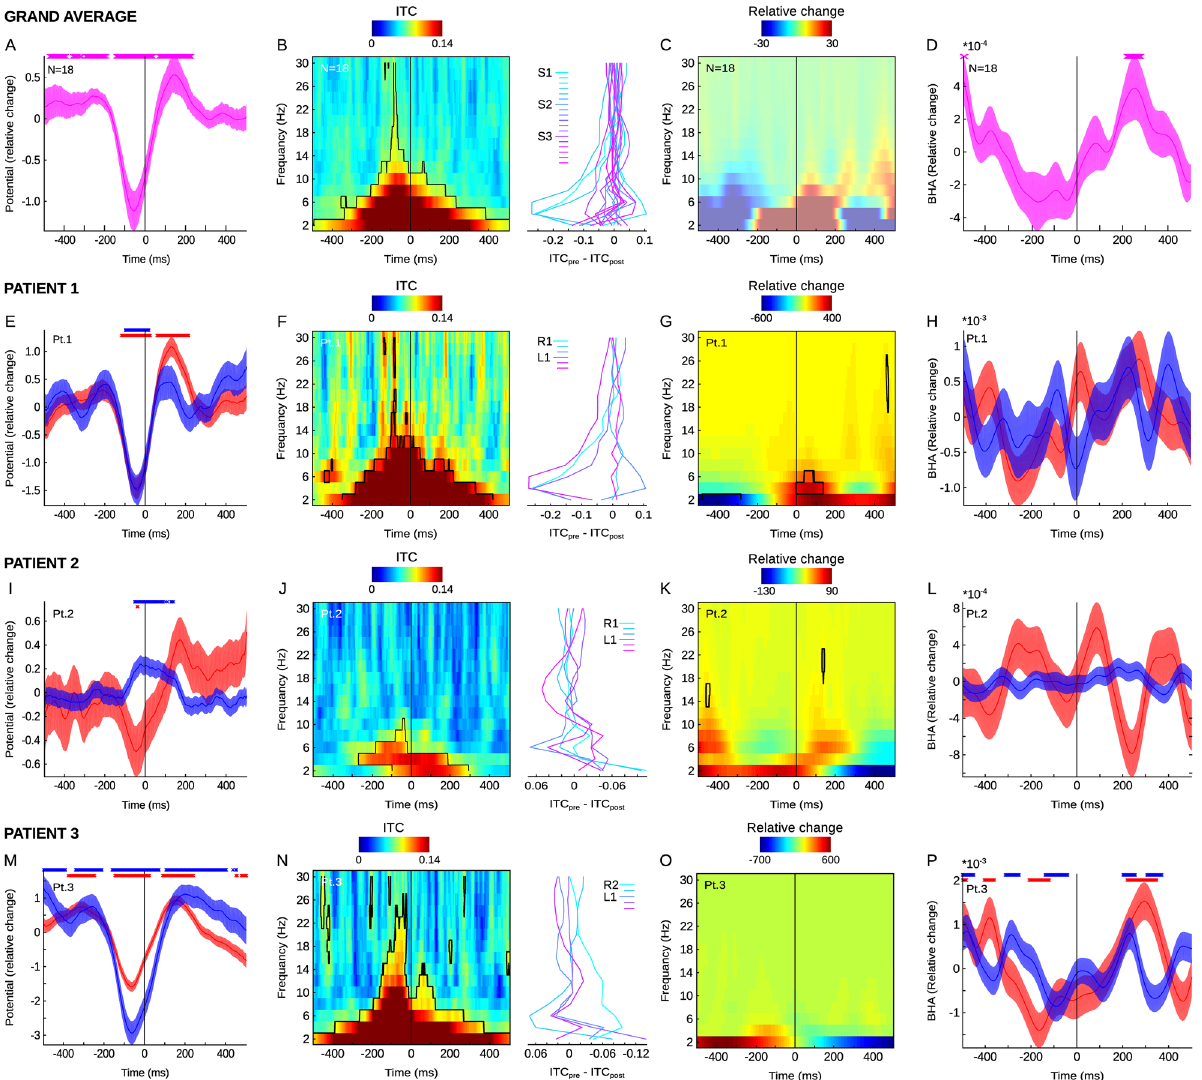
Figure 3. Blink offset-locked neural activity in human ANT. ( A ) Grand average for blink offset-locked field potentials (N = 18 ANT channels, 3 patients). Vertical lines show the point of blink offset (i.e., onset of visual input). Markers above indicate significant time points (permutation test p < 0.05). ( B ) Color map shows ITC (time on x-axis, frequency on y-axis). Contours depict significant time–frequency points (permutation test p < 0.05). Vertical black line indicates blink offset (i.e., the beginning of visual input). Line plots on the right side indicate ITC change from pre- (− 300: − 100 ms) to post- blink offset (0:100 ms) time window separately for each channel. ( C ) Color map shows blink offset locked power relative to trial average (time on x-axis, frequency on y-axis). No change from surrogate distribution (permutation test p < 0.05). ( D ) Blink offset locked BHA (80–180 Hz). Vertical black line indicates blink offset (i.e., beginning of visual input). Markers above indicate significant time points (permutation test p < 0.05). ( E ) Blink offset-locked field potentials (patient 1) from channels on the right ANT (blue) and left ANT (red). Vertical black lines show the point of blink offset (i.e., beginning of visual input). Markers above indicate significant time points (permutation test p < 0.05). ( F ) Same as B but data from patient 1. ( G ) Same as C but data from patient 1. Contours present change from surrogate distribution (permutation test p < 0.05) ( H ) Blink offset-locked BHA (patient 1) on the right ANT (blue) and left ANT (red). Vertical black lines show the point of blink offset. Data from patient 2 ( I – L ) and patient 3 ( M – P ) plotted with the same convention as ( E – H ). All results are controlled for multiple comparisons with Benjamini and Hochberg/Yekutieli false discovery rate procedure. Shading reflects standard error of the mean